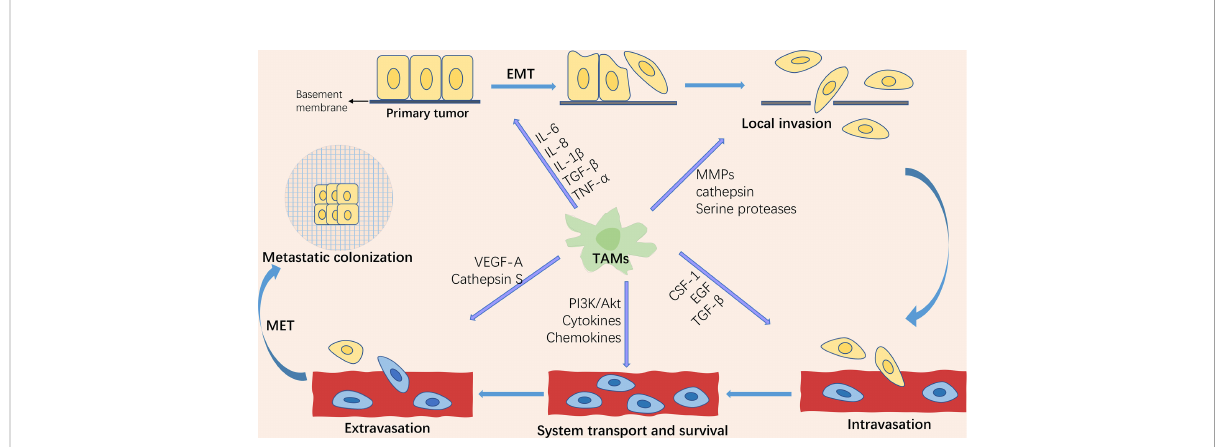
FIGURE 1 Schematic representation of the tumor invasion-metastasis cascade and the role of tumor-associated macrophages (TAMs) in tumor metastasis. The tumor invasion-metastasis cascade includes tumor cell EMT, invasion of the surrounding extracellular matrix and stromal cell layer, intravasation, survival and transport in the circulatory system, extravasation, survival in the distant tissue microenvironment, and colonization and growth at the metastatic site. TAMs are involved in regulating almost every step of the tumor invasion-metastasis cascade through the secretion of multiple